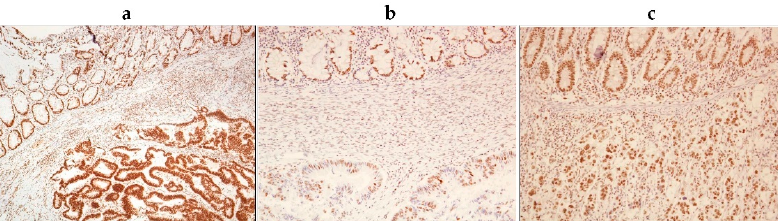
Figure 6. Representative microphotographs of immunohistochemical staining of phospho-nucleo- phosmin (Thr199) in colonic adenocarcinomas differing in BRAF mutational status. ( a ) Upper part of the picture showing normal colonic crypts, with moderate nuclear staining. Below is colonic adenocarcinoma with BRAF mutation showing strong nuclear and cytoplasmic staining; ( b ) upper part of the picture showing normal colonic crypts, with moderate nuclear staining. Below is co- lonic adenocarcinoma with KRAS mutation showing weak nuclear and negative cytoplasmic staining; ( c ) upper part of the picture showing normal colonic crypts, with moderate nuclear stain- ing. Below is colonic adenocarcinoma BRAF and KRAS wild types showing moderate nuclear and negative cytoplasmic staining. Magnification 100× (6a) and 200× (6b and 6c). Table 4. The immunohistochemistry staining intensity of nucleophosmin in colonic adenocarcino- mas differing in BRAF mutational status. BRAF mut BRAF wt N = 7 (33%) N = 14 (67%) Staining intensity mean mean p -value Nuclear 2 1.43 0.009 BRAF Cytoplasmic 1.86 0.86 0.005